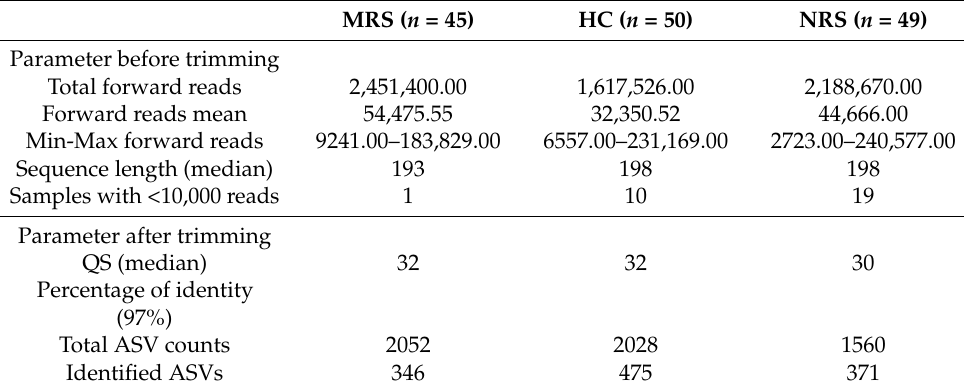
Figure 1. Relative abundances of bacterial taxa in the studied samples. Color sectors indicate taxa as indicated by tags on the right side of the figure; abundances are shown as percentages on the Y -axis. Type of sample is shown on top of the figures: MRS (mother rectal swab), HC (human colostrum), NRS (neonate rectal swab), while positive (+) or negative ( − ) SARS-CoV-2 genome detection by RT-ddPCR is shown at the bottom. ( A ) Pie charts show the top four abundant phyla, while “Other” includes phyla with < 1% relative abundance (Supplementary Materials Table S2). ( B ) Bar plots show the top 25 abundant families (Supplementary Materials Tables S3–S5), while “Other” groups families with < 2.5% relative abundance (Supplementary Materials Table S6). Table 3. Sequencing summary for all samples of this study.